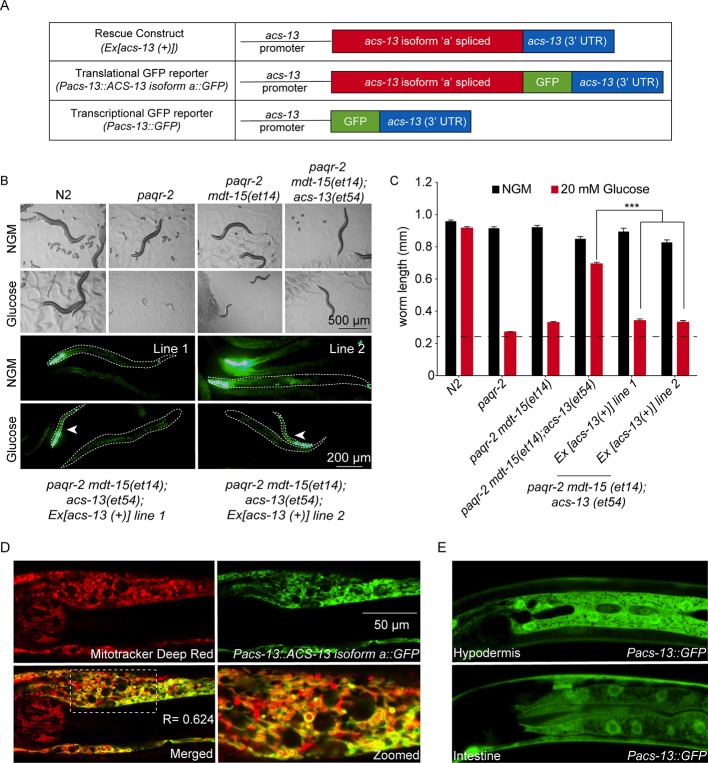
The ACS-13 protein localizes to mitochondria and is expressed in intestine and hypodermis.(A) Cartoon representation of the acs-13 constructs created for this study. (B) Bright field photographs of worms with the indicated genotypes cultivated on control plates (NGM) or plates containing 20 mM glucose (top two rows), and epifluorescence images of two independent lines of transgenic paqr-2 mdt-15(et14) worms carrying the myo-2::GFP marker as well as the wild-type acs-13(+) rescue construct and cultivated either on NGM or 20 mM glucose plates (bottom two rows; several worms are outlined with dashed lines). Note how presence of the acs-13(+) construct in both transgenic lines abolishes the glucose resistance of paqr-2 mdt-15(et14); acs-13(et54) double mutants (examples indicated by arrowheads). (C) Length measurements of worms cultivated as in B (n = 20). Only the statistical significances of interest are indicated, where ***: p<0.001. (D) Confocal image of the anterior portion of an N2 worms at the L1 stage stained with Mitotracker Deep Red (red) and carrying the Pacs-13::ACS-13 isoform a::GFP translational reporter (green). Co-localization is indicated by yellow hues in the merged and zoomed panels. Note the strong colocalization on the periphery of mitochondria, indicating that ACS-13 localizes to the mitochondrial membrane. R is the Pearson correlation coefficient between the two fluorophores. (E) Confocal image of N2 worms of the L1 stage and carrying the Pacs-13::GFP transcriptional reporter expressed in hypodermis and intestine.